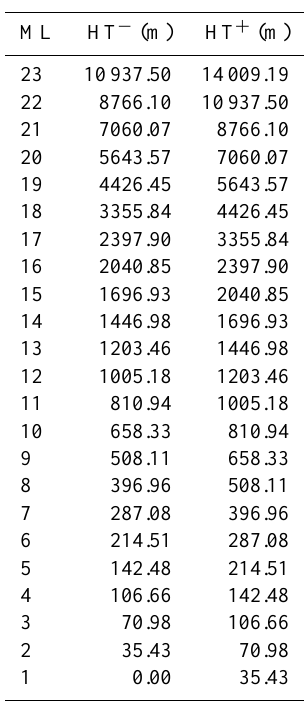
Table 2. Vertical grid structure of the EURAD-IM-SVA v1.0 for the reference state 47.85 ◦ N, 9.50 ◦ E. Given are model level (ML) and height above ground (HT) in metres (m). The superscripts + and − indicate the upper and lower boundaries of the associated layer. ML HT −